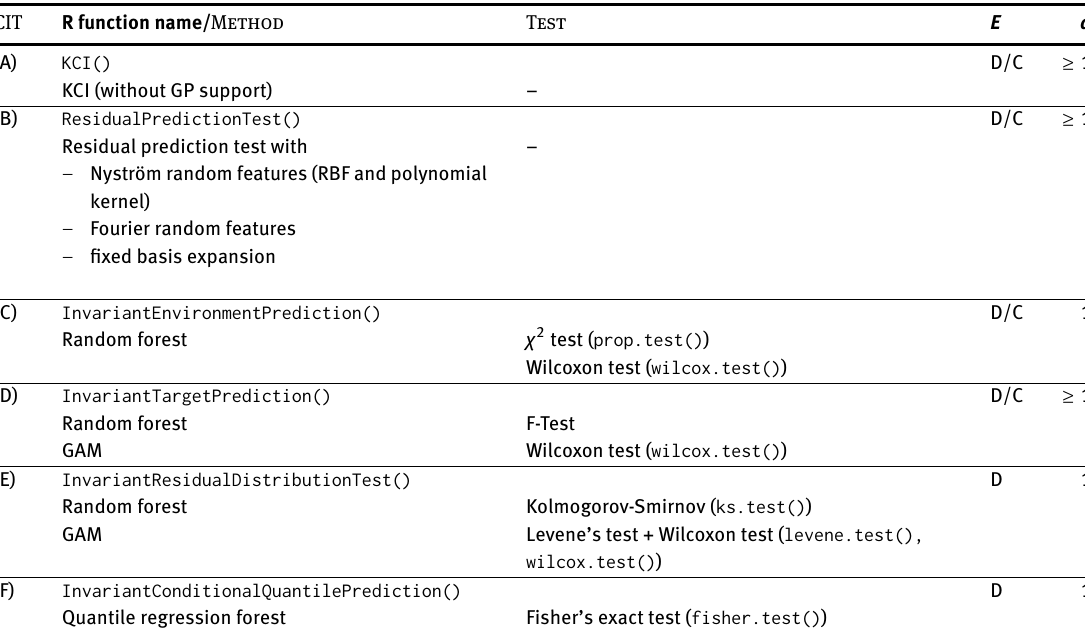
Table 2: Overview of implemented test combinations in CondIndTests